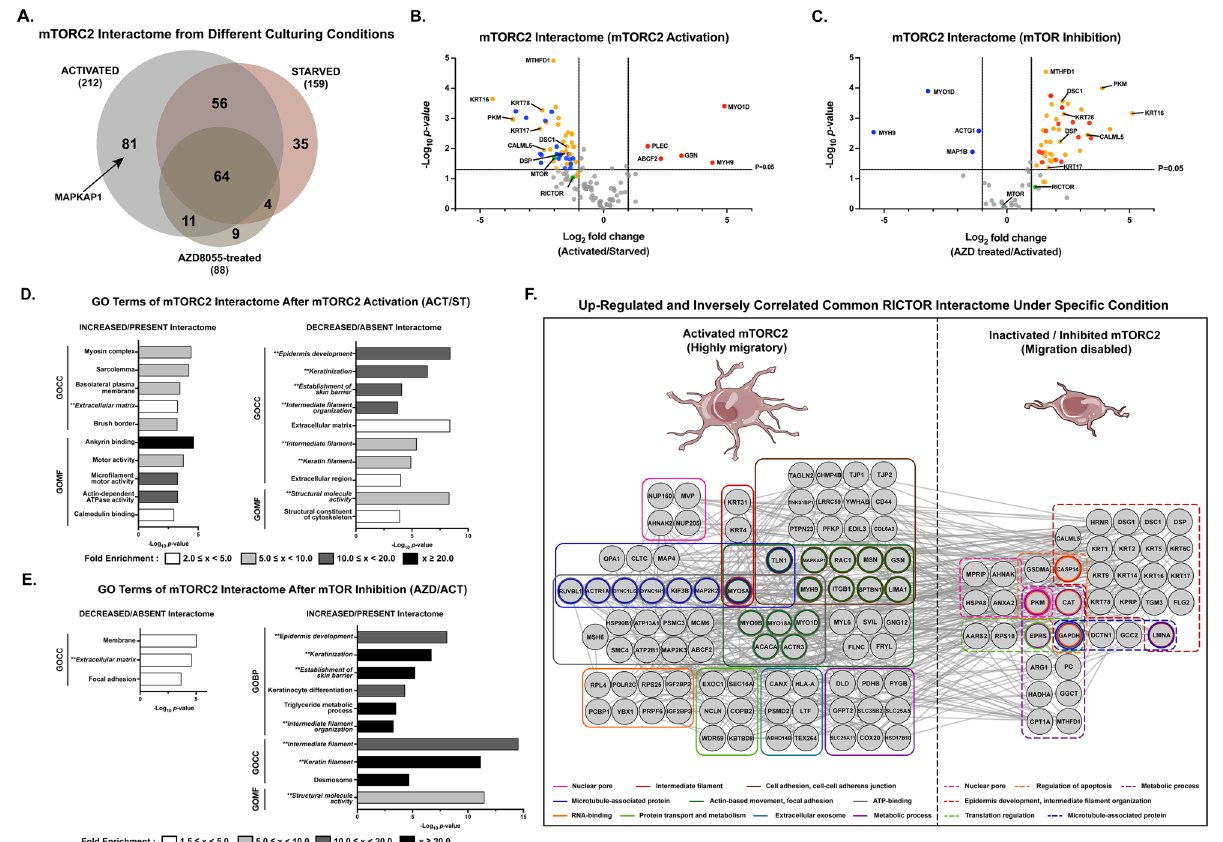
Figure 4. Quantification of the mTORC2 interactome under cell migration-associated conditions. (A) Overlap of the mTORC2 interactome identified from AP-MS experiments performed in U87MG cells under activated, starved, and 2.0 µM AZD8055-treated conditions. (B,C) Volcano plots of the results of AP-MS experiments in (A) showing changes in mTORC2-associated proteins by serum-stimulated mTORC2 activation in (B) and AZD8055-mediated mTOR inhibition in (C) ; n = 3 biological replicates. Proteins with log 2 fold change (LFQ ACT/ST or LFQ AZD/ACT) ≥ 1, p < 0.05 are highlighted in red, while proteins with log 2 fold change ≤ -1, p < 0.05 are highlighted in blue. Statistical significance was calculated from the LFQ values of each common protein of the two conditions using an unpaired two-sided Student’s t-test. Green circles are known mTORC2-associated proteins. Inversely regulated identical proteins downregulated in ACT/ST and upregulated in AZD/ACT are shown in orange. (D,E) Gene ontology analysis of the mTORC2 interactome increased/present and decreased/ absent by mTORC2 activation ( D) and mTOR inhibition (AZD8055 treatment) ( E) . Top-ranked -log 10 ( p -value) GOBP, GOCC, and GOMF terms with FDR < 0.05 are shown, and the bar colors represent the fold enrichment of each specific term. (F) Protein–protein interaction network of the mTORC2 interactome upregulated in each specific condition with the distinguished phenotype (activated/highly migratory or inhibited/migration disabled) and found to be downregulated in the opposite condition. All candidate proteins shown in the network were significantly changed with fold change ≥ 2 and p -value < 0.05. Proteins were categorized into various groups labeled by different colors depending on their common associated biological processes, cell components, or functions. Circles with two or more colors represent proteins related to several gene